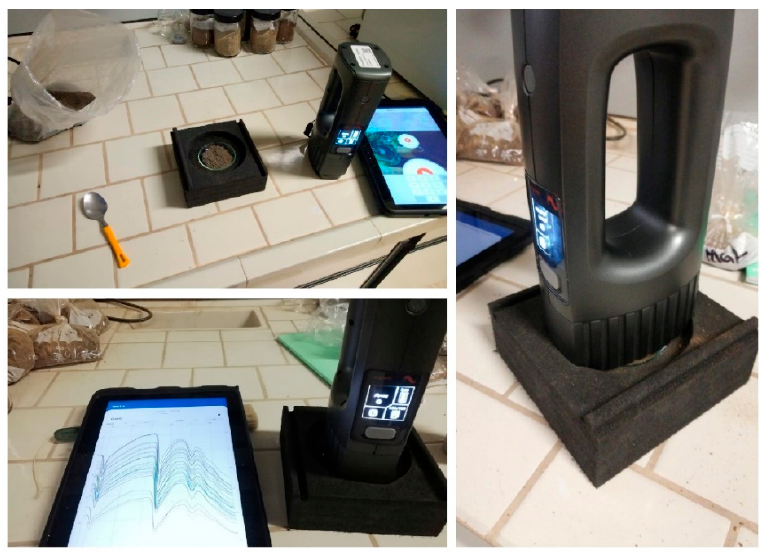
Figure 2. The spectral measurements carried out by Neospectra Scanner. All the measurements were visualized and recorded in the dedicated Android tablet, connected by bluetooth signal.